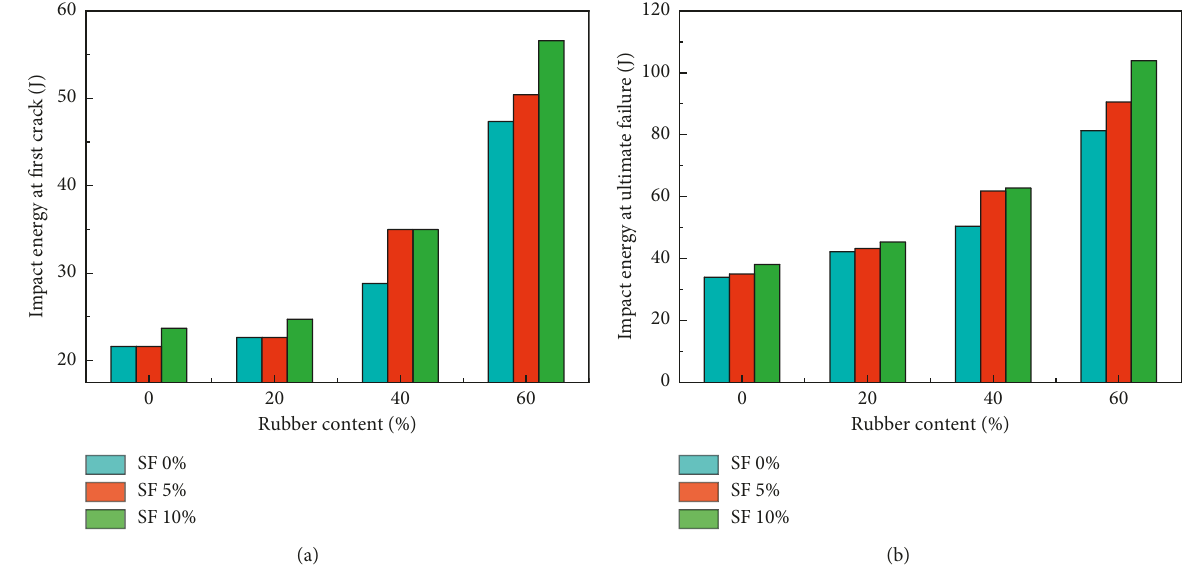
Figure 9: Impact energy at (a) first crack and (b) ultimate failure.